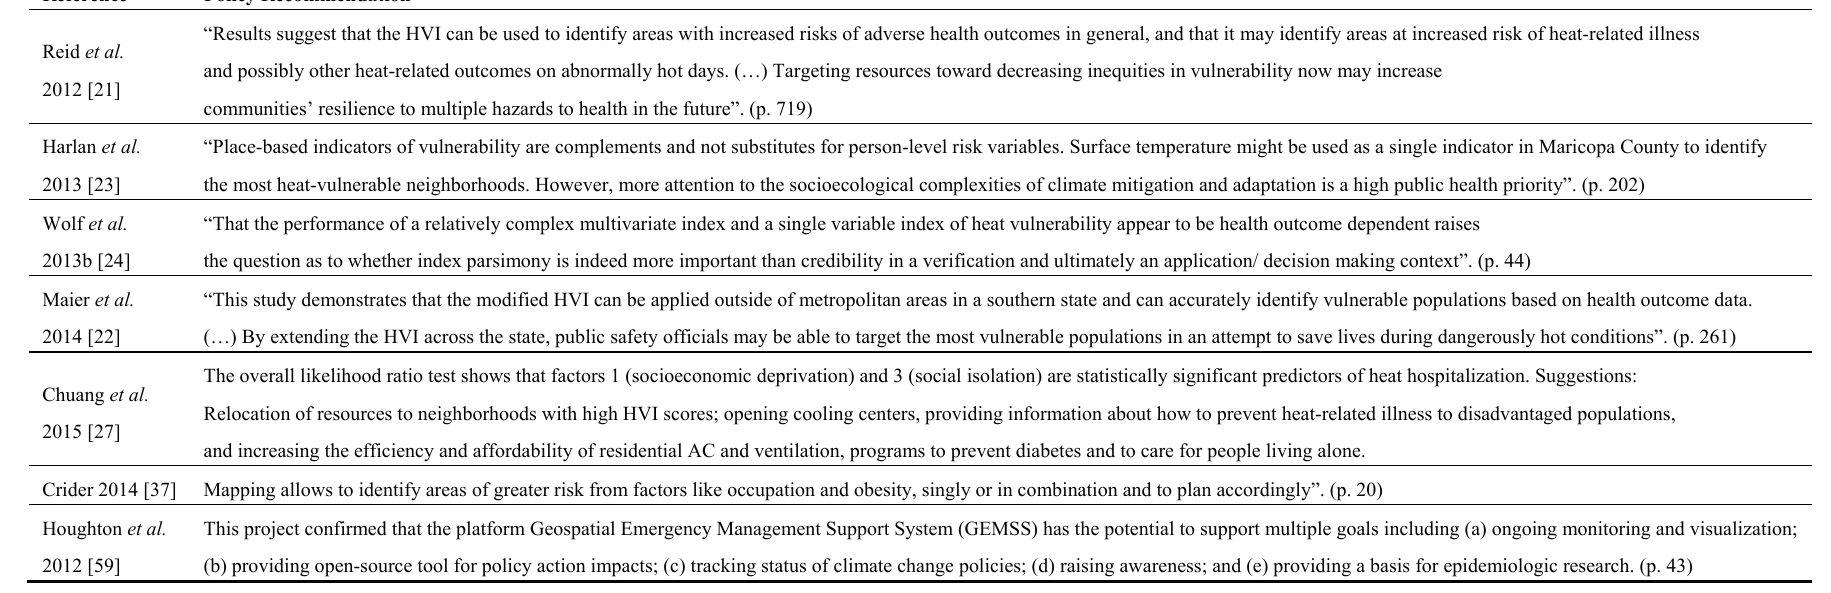
Table A2. Policy recommendations “ a-priori ”/inductive heat vulnerability mapping using health data to test the index.